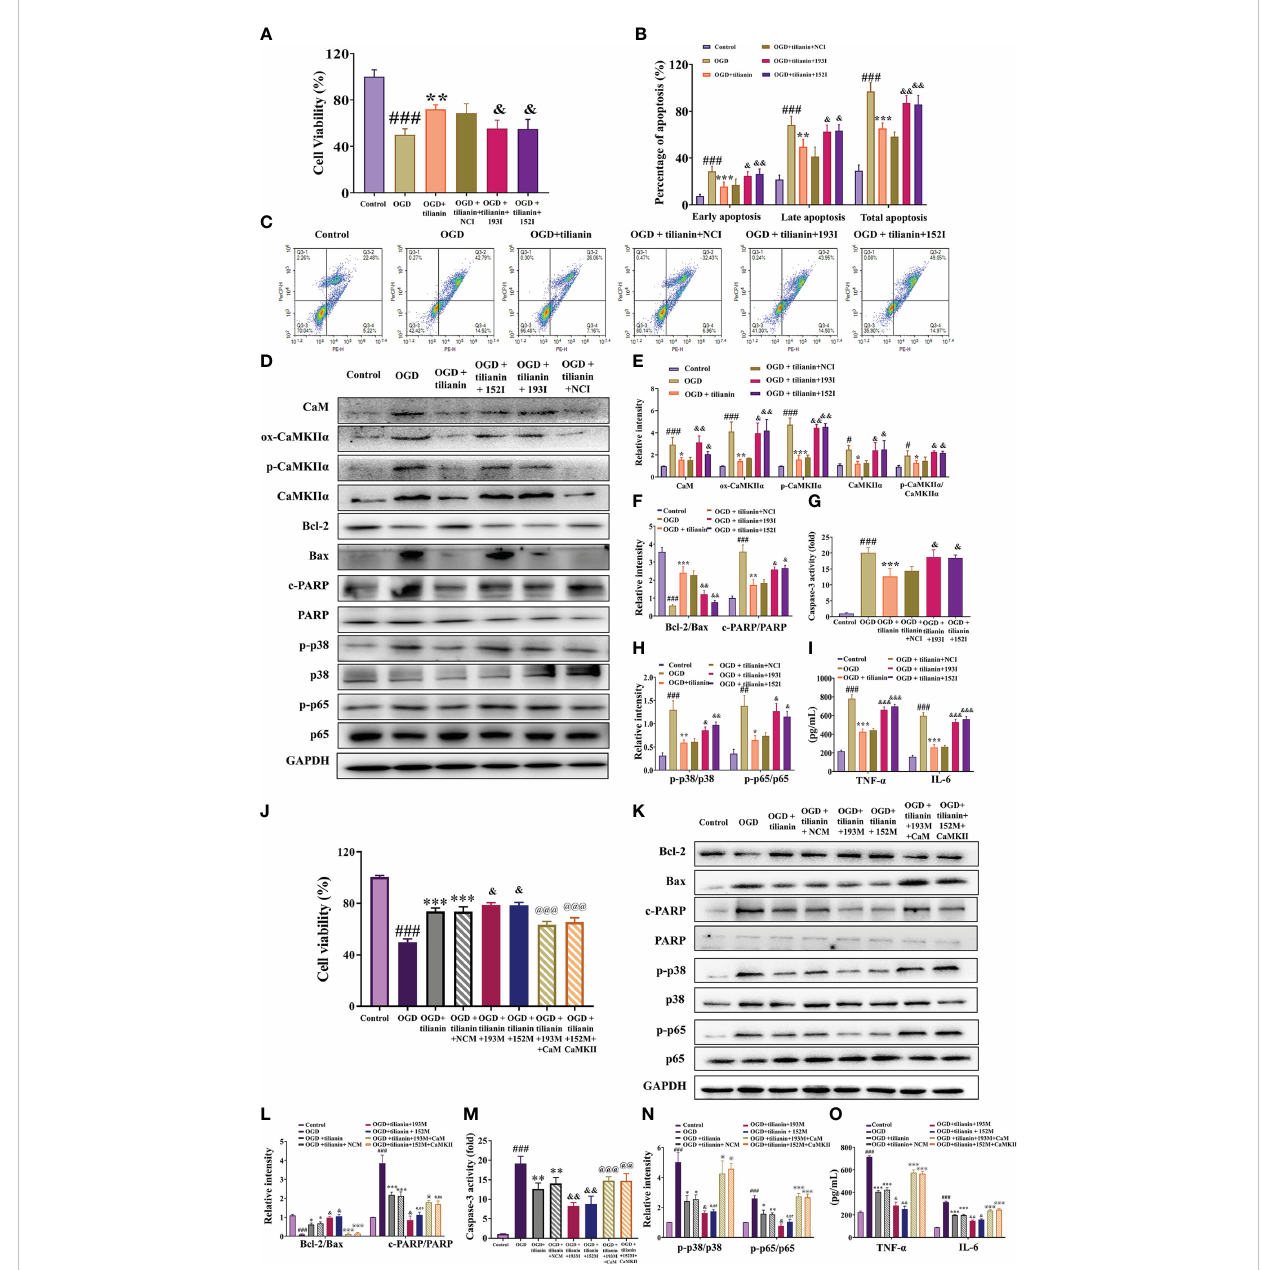
FIGURE 10 Effects of miR-193b-3p/CaM and miR-152-3p/CaMKII dysregulation on the neuroprotective effects of tilianin in vitro . (A) The miR-193b-3p and miR- 152-3p inhibitors reversed the positive effect of tilianin on the viability of OGD cells. (B) Quantitative analysis of the proportion of apoptosis. (C) Representative images of the apoptosis of OGD cells among different groups. (D) Representative Western blot bands for CaM, ox-CaMKII a , p- CaMKII a , CaMKII a , Bcl-2, Bax, c-PARP, total PARP, p-p38, p38, p-p65, and p65 in the different groups. (E) Quantitative analysis of the ratios of CaM, ox-CaMKII a , p-CaMKII a , CaMKII a , and p-CaMKII a /CaMKII a (F) Quantitative analysis of the ratios of Bcl-2/Bax and c-PARP/PARP. (G) Caspase-3 activity in OGD-injured cells assessed by ELISA. (H) Quantitative analysis of the ratios of p-p38/p38 and p-p65/p65. (I) Levels of TNF- a and IL-6 in OGD-injured cells assessed by ELISA. (J) Effects of overexpression of miR-193b-3p, miR-152-3p, CaM, and CaMKII on the viability of OGD-injured cells. (K) Representative Western blot bands for Bcl-2, Bax, c-PARP, total PARP, p-p38, p38, p-p65, and p65 in OGD-injured cells. (L) Quantitative analysis of Bcl-2/Bax and c-PARP/PARP. (M) Caspase-3 activity in OGD-injured cells assessed by ELISA. (N) Quantitative analysis of the p-p38/p38 and p-p65/p65 ratios. (O) Levels of TNF- a and IL-6 in OGD-injury cells assessed by ELISA. Results represent the mean ± SD, n =3, ## P <0.01, ### P <0.001 vs. control, * P <0.05, ** P <0.01, *** P <0.001 vs. OGD, & P <0.05, && P <0.01 vs. OGD+tilianin+NCI/NCM, @ P <0.05, @@ P <0.01, @@@ P <0.001 vs. OGD+